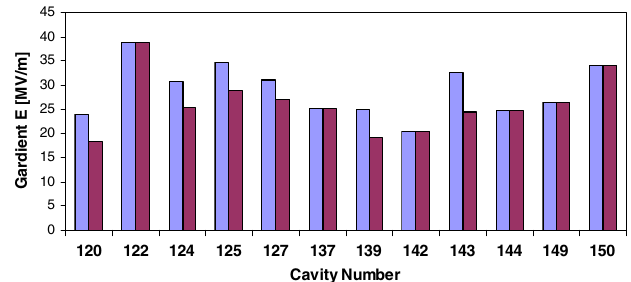
FIG. 5. (Color) Test results of cavities prepared for test accord- ing to the ‘‘final EP’’ treatments cycle. Blue: maximum accel- eration gradient Eacc; Red: acceptance gradient Eacpt.